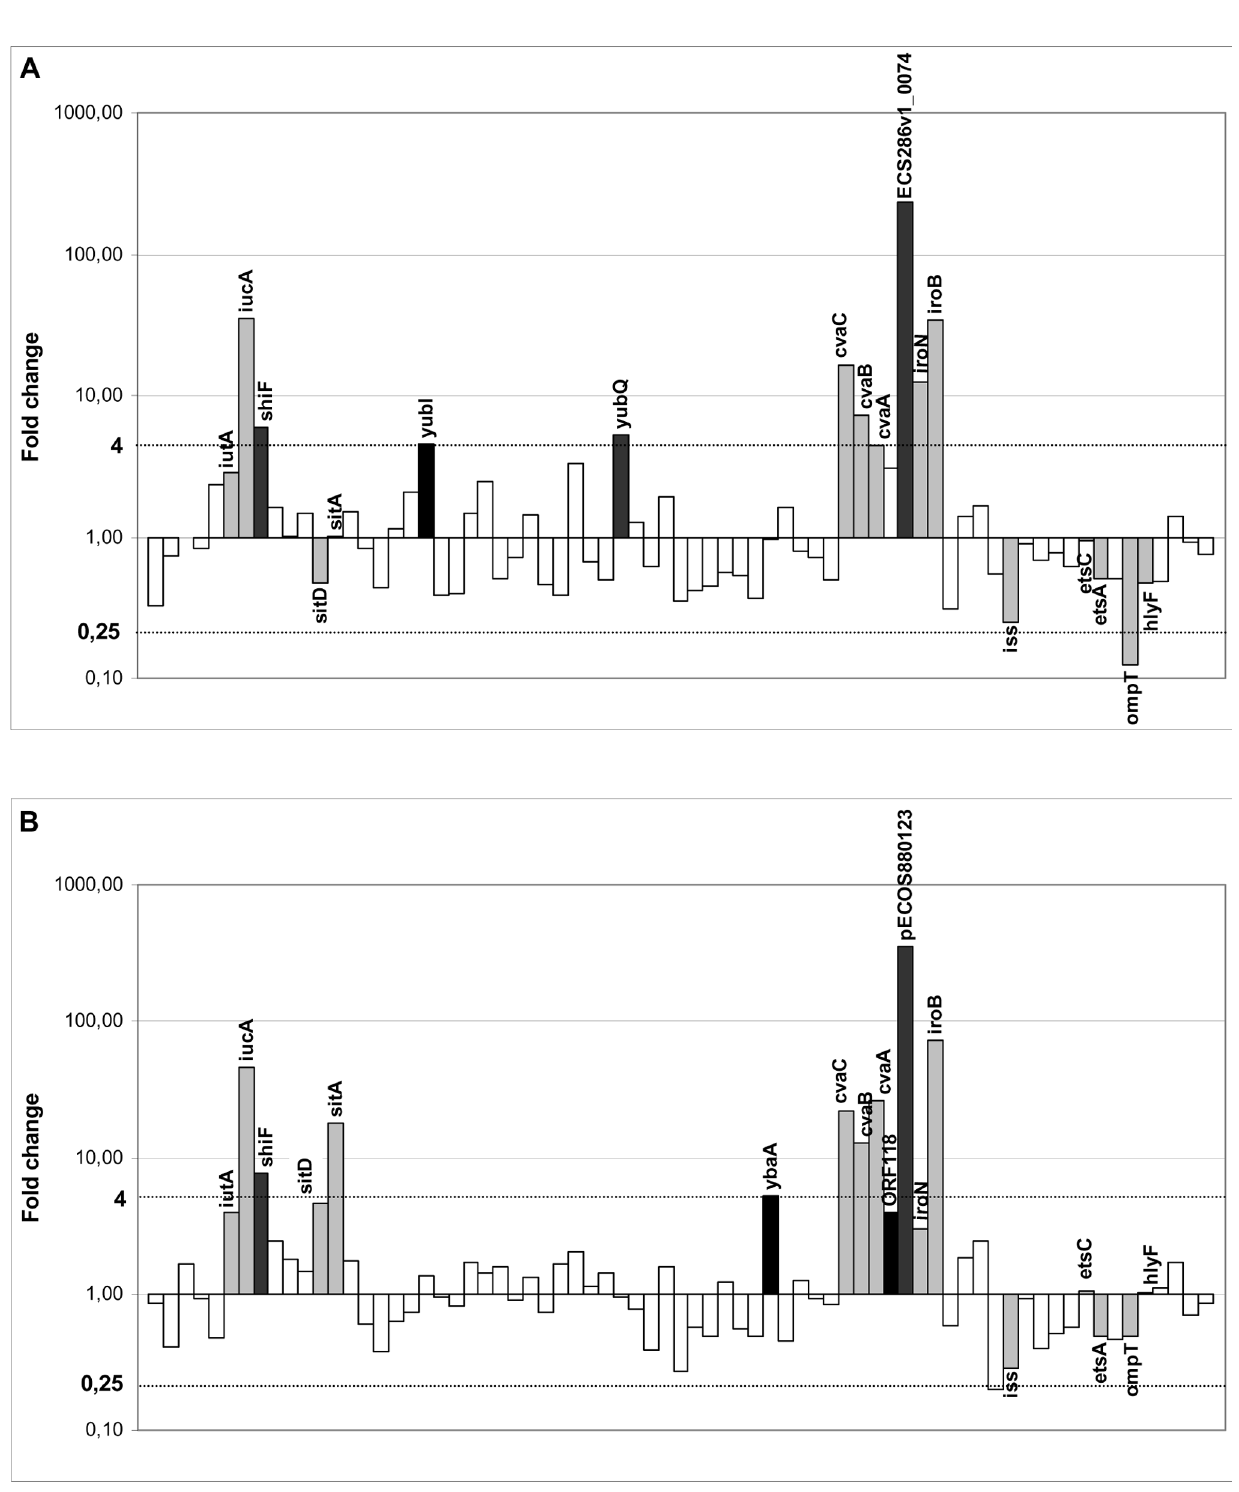
Figure 3. Fold changes of RNA transcripts of pS286colV (A) and pS88 (B) in iron deficiency environment. Relative expression of transcripts were calculated between growth in LB with an iron chelator comparatively to growth in LB. Only genes characteristics of the Conserved Virulence Plasmidic (CVP) region (grey) and other genes upregulated (black) are named. Fold changes were calculated by 2 2 DD Ct method.